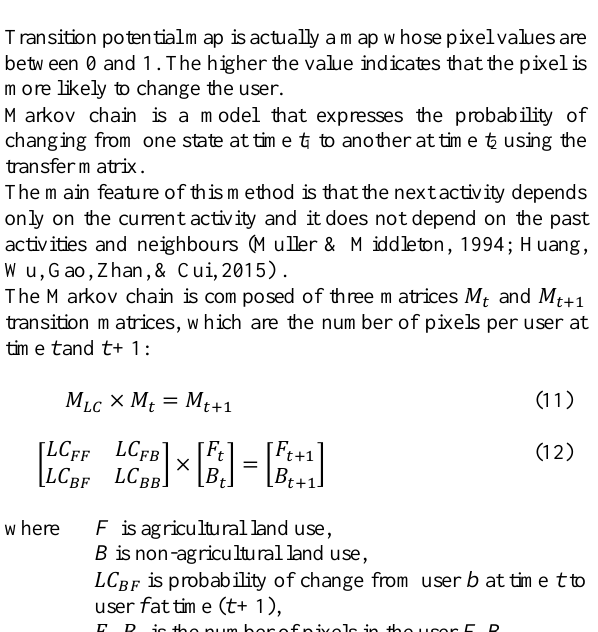
Figure 6. Transition potential map